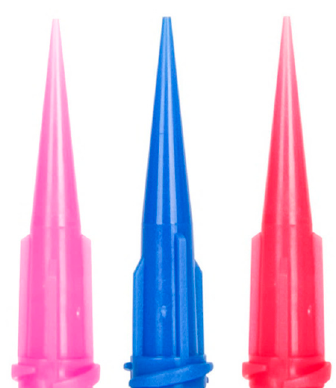
Figure 1. Cellink bioprinting conical tips. From left to right: 20, 22, and 25G. Reproduced with permission from Cellink ® .